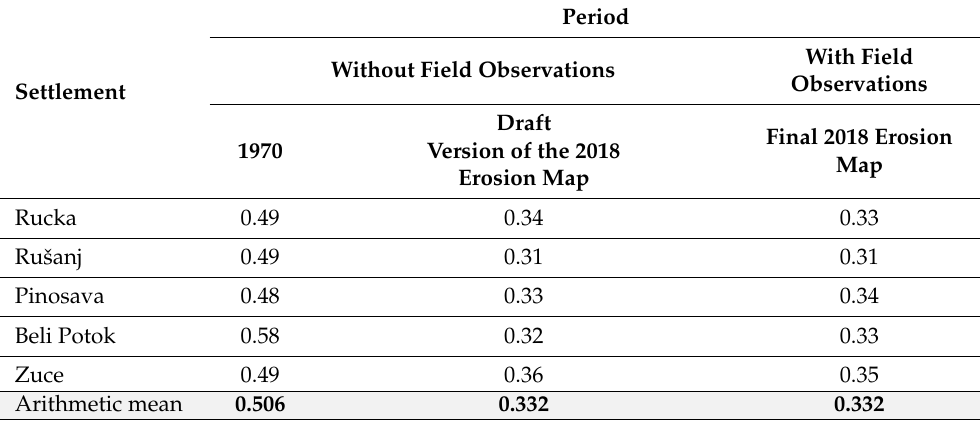
Table 3. Average erosion coefficient values by